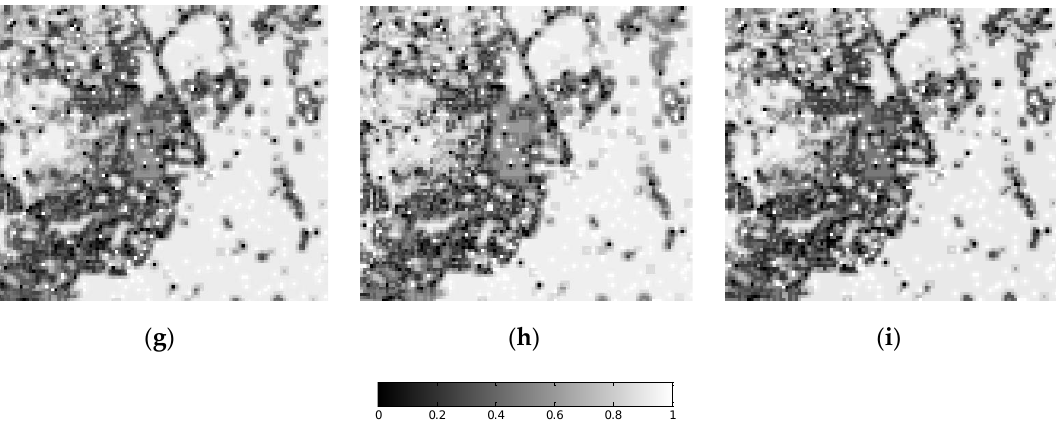
Figure 3. The probability maps generated by different methods: ( a ) indicator kriging; ( b , c ) logistic regression, without and with spatial correlation considered, respectively; ( d , e ) logistic regression and kriging, without and with spatial correlation considered in regression, respectively; ( f , g ) logistic regression (without considering spatial correlation) and kriging, with extra training samples collected by random and adaptive sampling, respectively; ( h , i ) logistic regression (considering spatial correlation) and kriging, with extra training samples collected by random and adaptive sampling, respectively.